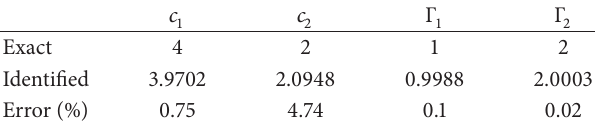
Table 2: Identified coefficients compared with the exact ones: transient region.